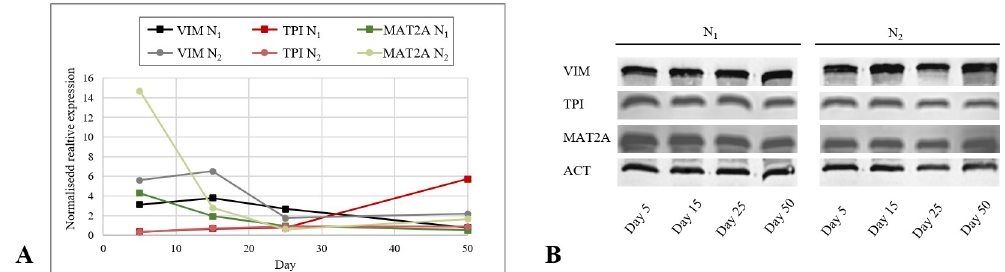
Fig 4. mRNA and protein expression of VIM, TPI and MAT2A in native cells. A. Expression of VIM, TPI and MAT2A in native endothelial cells of both batches during the angiogenic cascade. Decreasing expression in VIM and MAT2A and increasing in TPI was statistically proven under the use of Wilcoxon rang sum test ( p < 0.05). B. Western blot analysis of VIM, TPI and MAT2A in native cells of HD1 and HD2 at day 5, 15, 25 and 50. ACT was used as internal control. � p < 0.05, �� p < 0.01, ��� p <